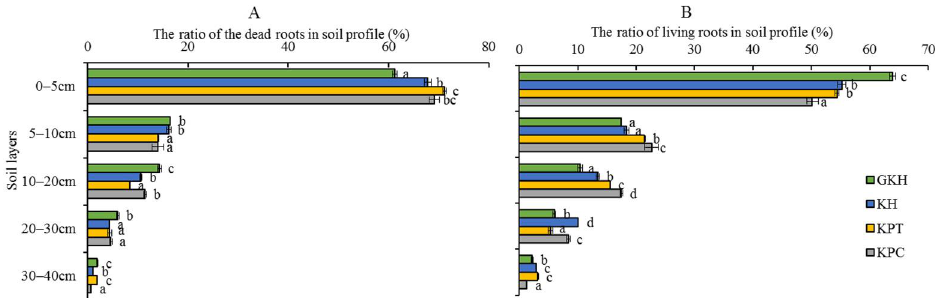
Figure 3. Quantity of two types of roots—( A ) The ratio of biomass of living root in soil profile and ( B ) the ratio of biomass of dead root in soil profile at different grazing intensities: GKH (3.75 ± 0.75 sheep/ha), KH (7.25 ± 0.25 270 sheep/ha), KPT (8.50 ± 0.35 sheep/ha), and KPC (11.75 ± 0.95 sheep/ha). Notations: different letters indicate significant differences between pastures ( α = 0.05).